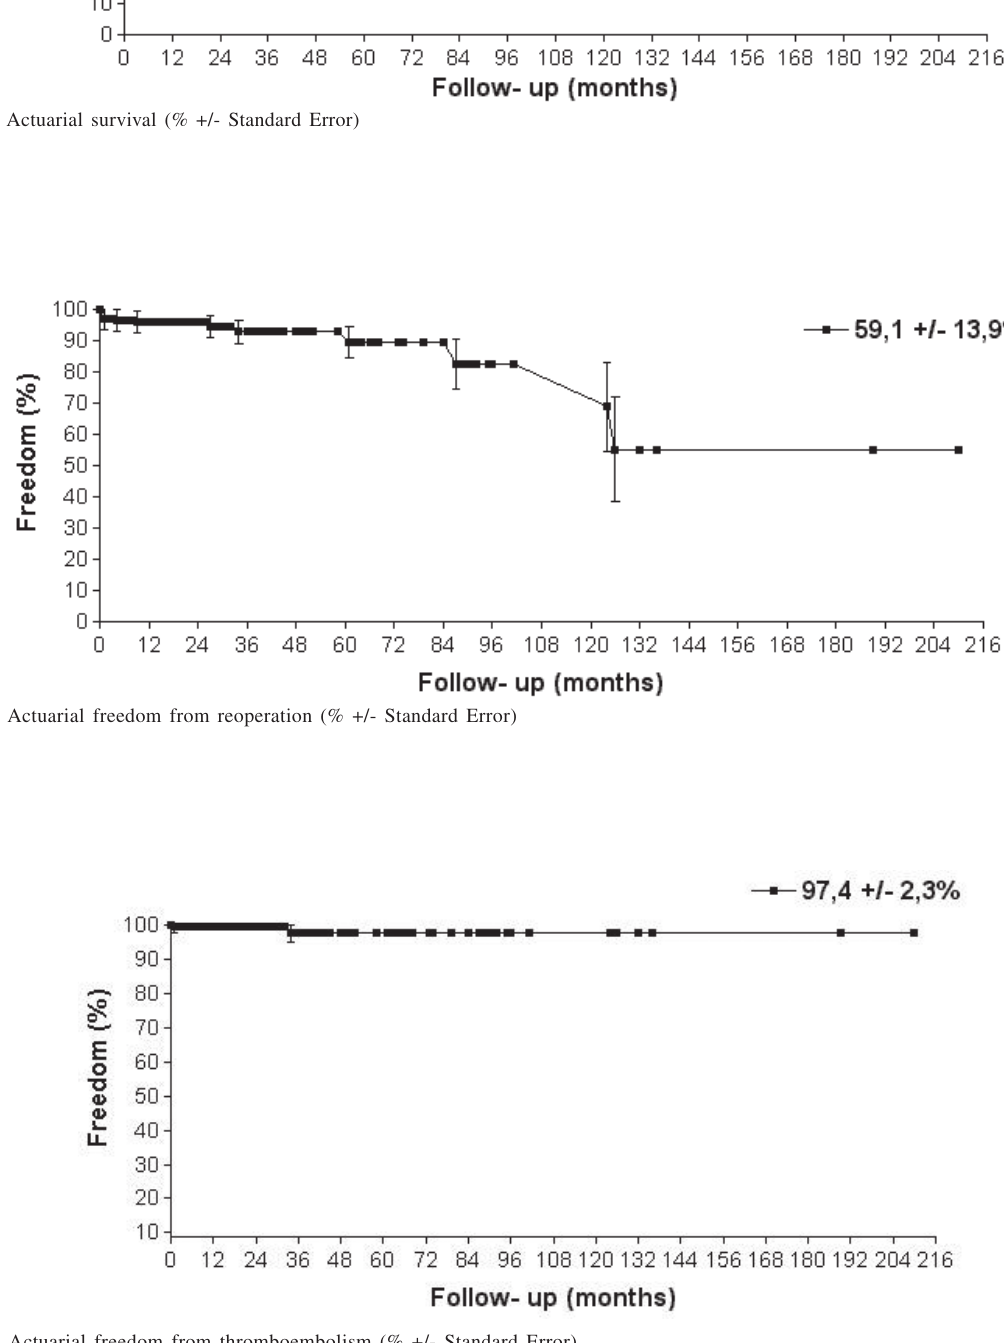
Figure 4 - Actuarial freedom from thromboembolism (% +/- Standard Error)